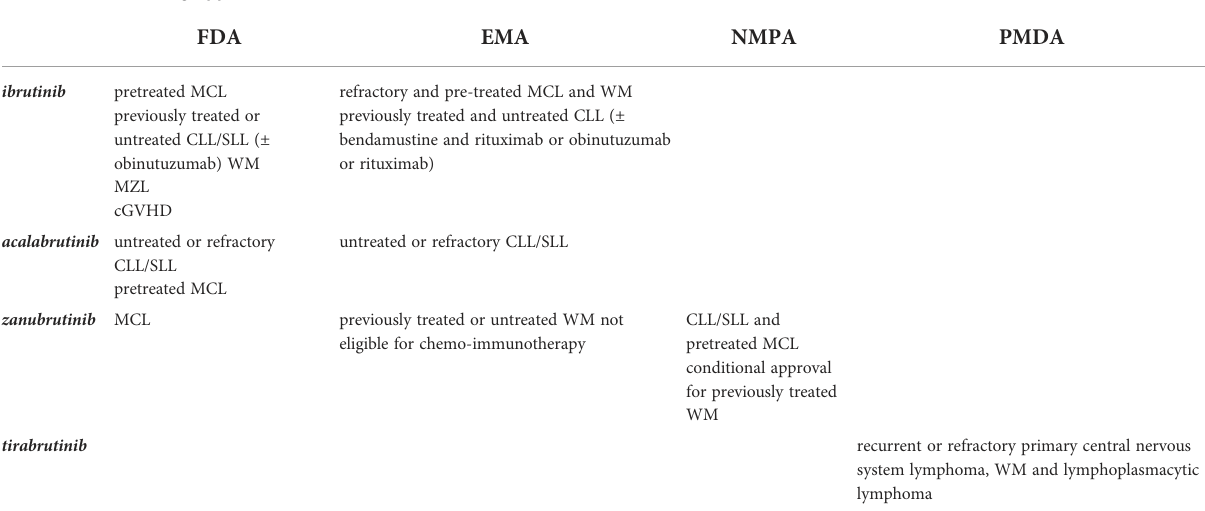
TABLE 1 BTKis already